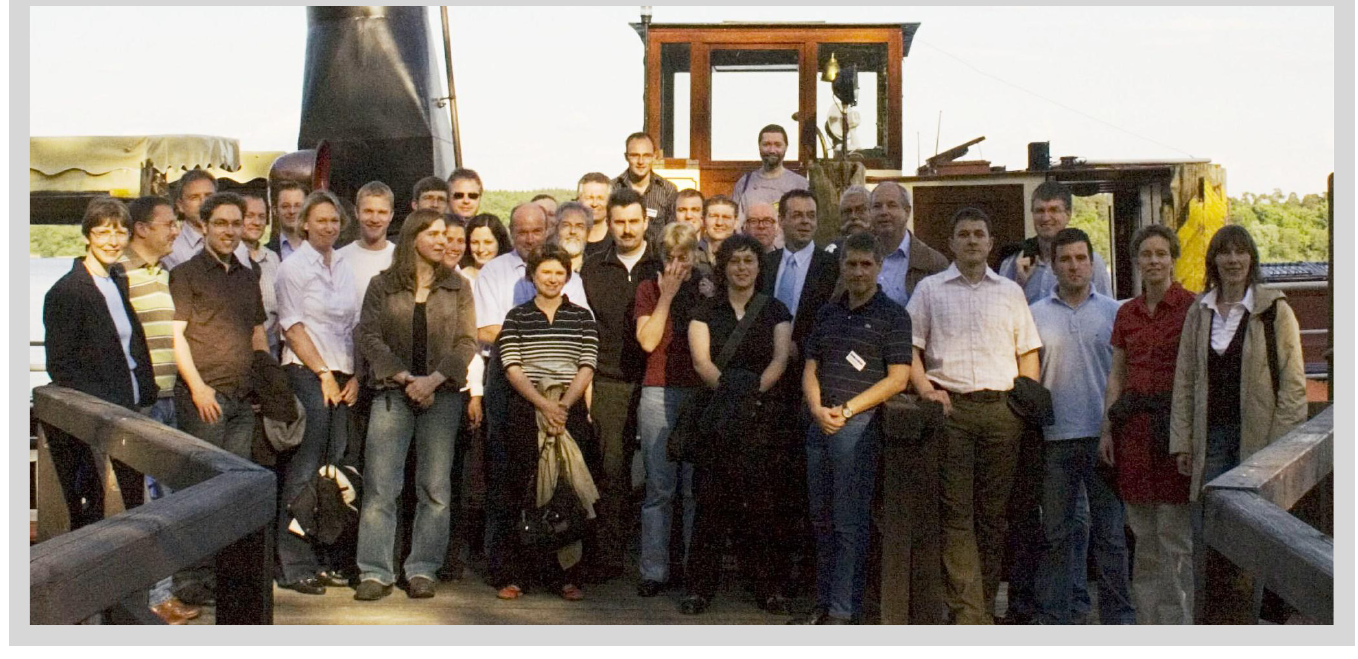
Figure 1 (above): Participants of the 2D/3D rheology seminar in front of the steamer “Gustav”, on which the participants of the seminar made an excur- sion on the rivers and lakes of Potsdam. Figure 2: Principle of a shear experi- ment at the interface between two